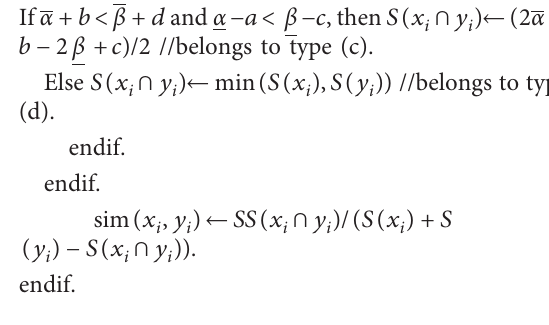
y i and i . (a) Type (a), (b) type (b), (c) type (c), and (d) type